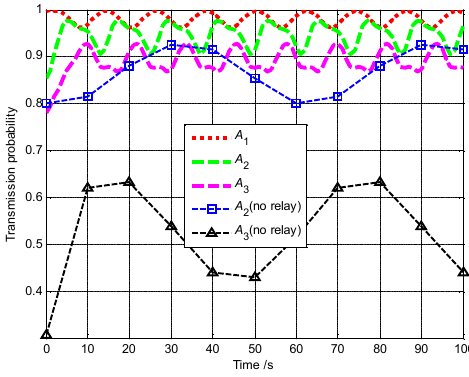
Figure 35. The communication performances of A 1 , A 2 and A 3 (Scenario 4).